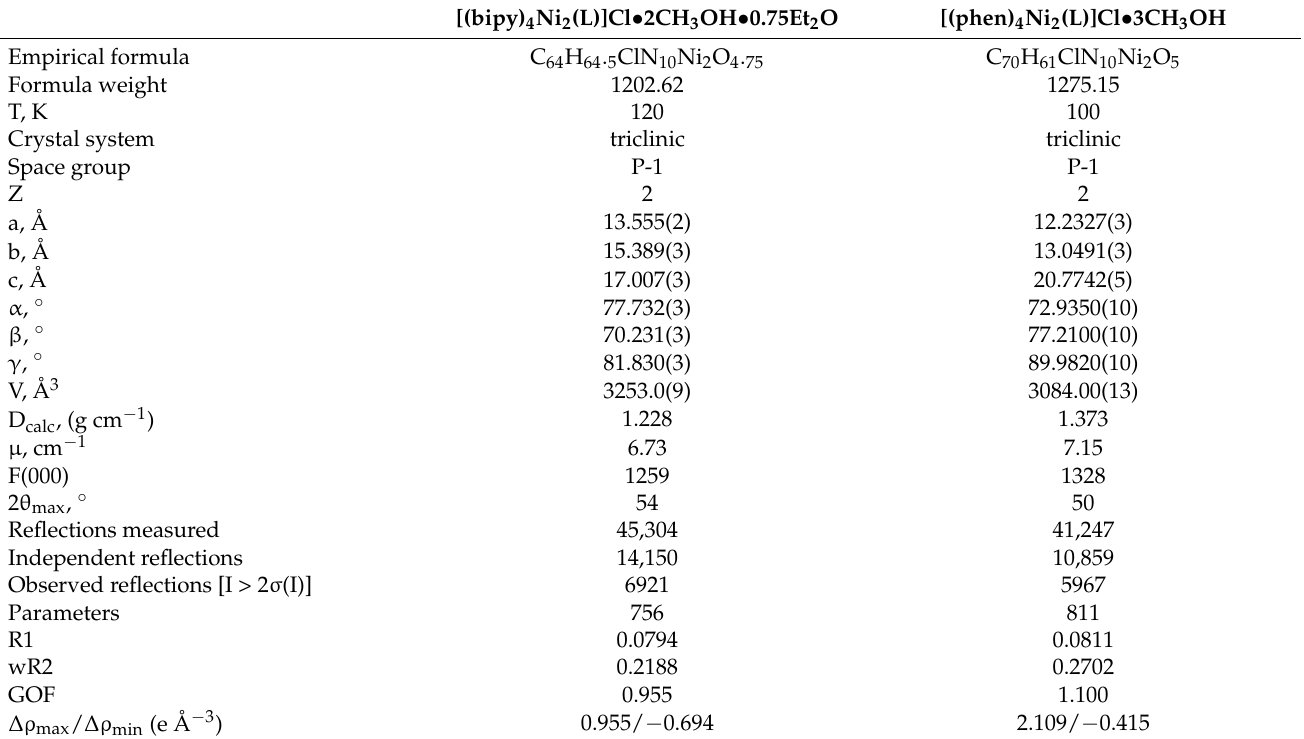
Table 2. Crystal data and structure refinement parameters for [(bipy) 4 Ni 2 (L)]Cl • 2CH 3 OH • 0.75Et 2 O and [(phen) 4 Ni 2 (L)]Cl • 3CH 3 OH